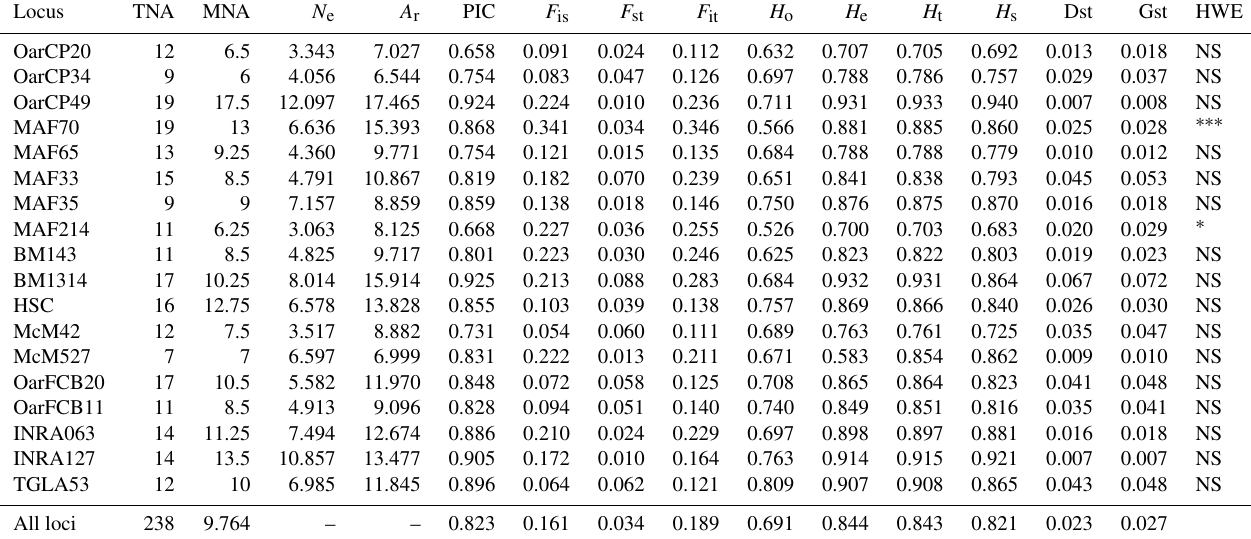
Table 1. Genetic diversity parameters estimated for 18 microsatellite markers over all populations. TNA – total number of alleles; MNA – mean number of alleles; N e – effective number of alleles; A r – allelic richness; PIC – polymorphic information content for each locus; F statistics ( F is , F st , F it ); H o – observed heterozygosity; H e – expected heterozygosity; H t – Nei’s gene diversity; H s – diversity within breeds; Dst – diversity between breeds; Gst – coefficient of gene differentiation; HWE – test for significant deviation from Hardy–Weinberg equilibrium with the hypothesis of the heterozygote excess ( ∗ p ≤ 0 . 05; ∗∗ p ≤ 0 . 01; ∗∗∗ p ≤ 0 . 001). Locus TNA MNA